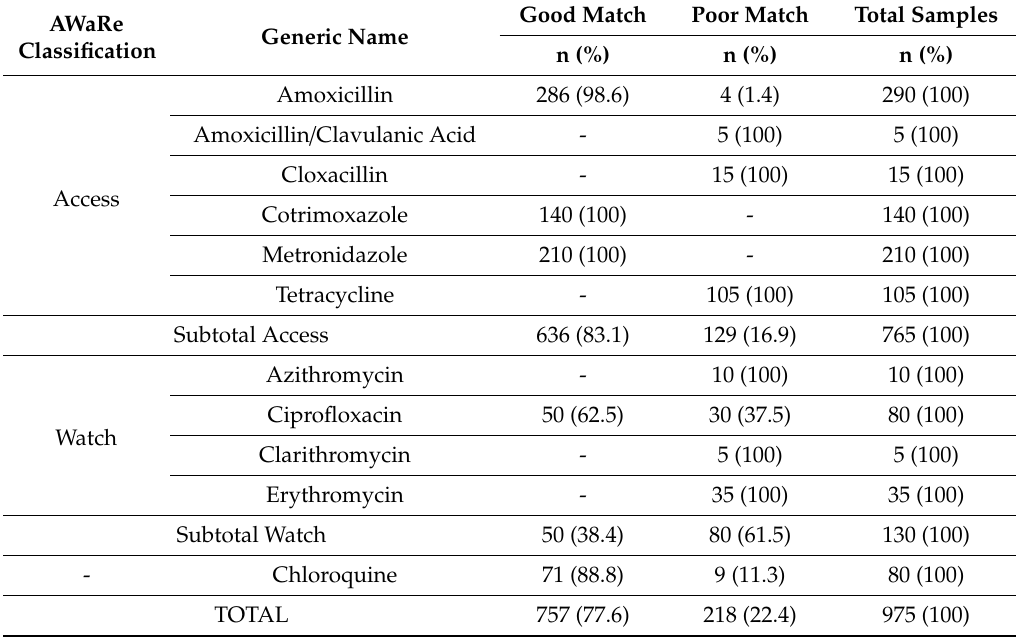
Table 2. Description of the spectral match quality (“Good” or “Poor”) of the analyzed sample of antimicrobials acquired in di ff erent street markets in Port-au-Prince (Haiti). The di ff erent medicines have been categorized according to the AWaRe classification (see